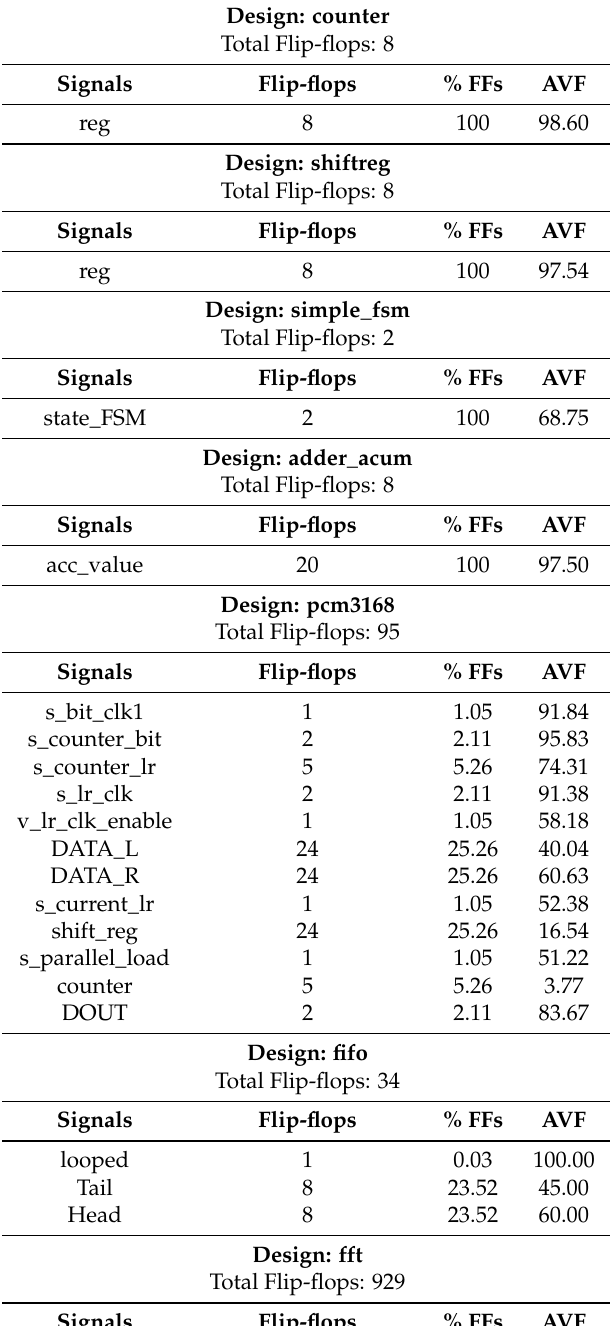
Table 5. Designs under test, synthesized with Synplify, with register signals classified by percentage of total number of flip-flops and Architectural Vulnerability